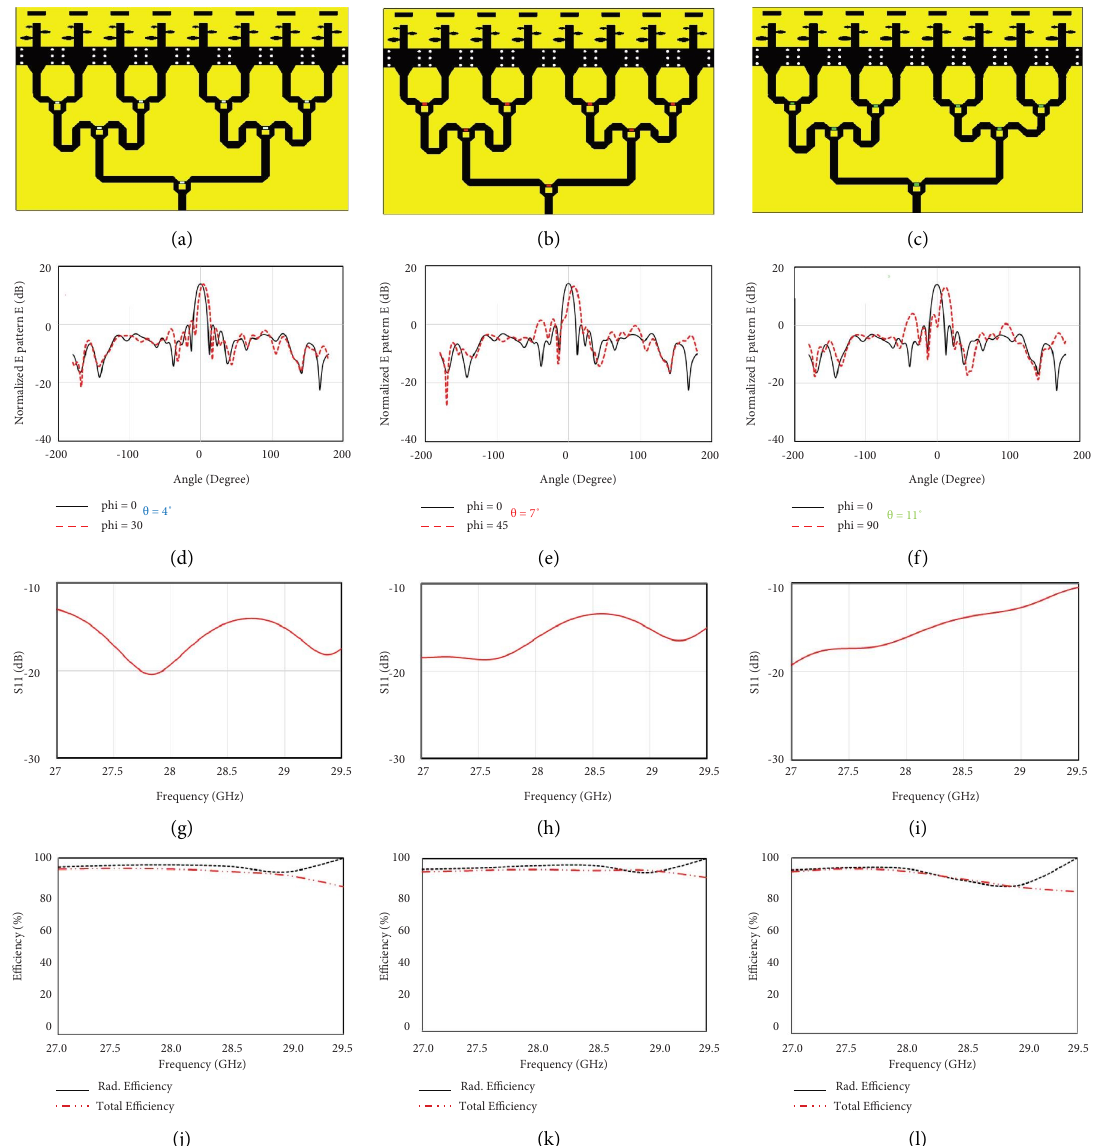
Figure 10: a). Phase diference 30 degree( θ � 4 ° ), d, g, j are results of normalized E – pattern with respect to 0 ° phase diference, S Efciency of this state, respectively. (b). Phase diference 45 degree( θ � 7 ° ), e, h, k are results of normalized E-pattern with respect to 0 ° phase diference, S 11 and Efciency of this state respectively. (c). Phase diference 90 degree( θ � 11 ° ), f, i, l are results of normalized E-pattern with respect to 0 ° phase diference, S 11 and Efciency of this state